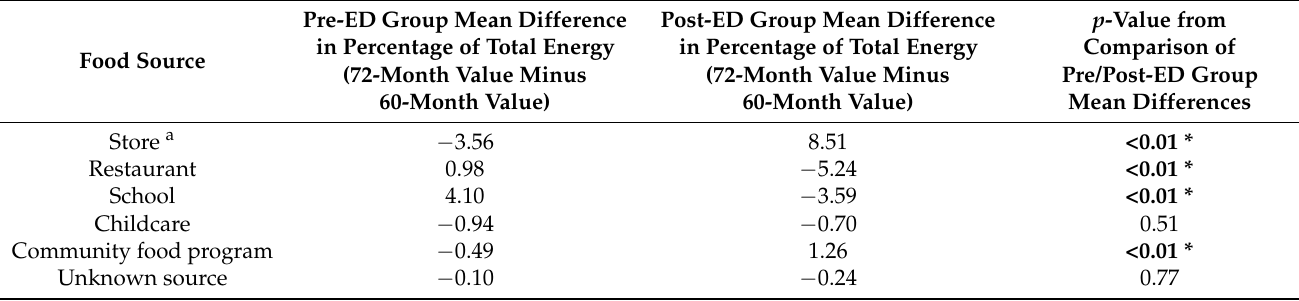
Table 2. Mean within-person differences between 60- and 72-month sources of dietary energy as a percentage of total energy for pre-emergency-declaration (pre-ED) and post-emergency-declaration (post-ED) groups.